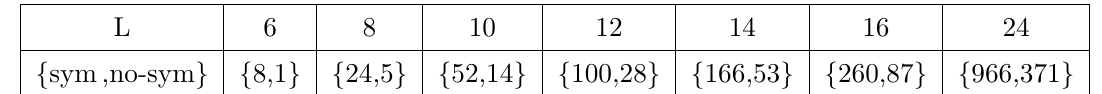
Table 8 . Number of solutions of the so (6) spin chain of length L and roots them according to